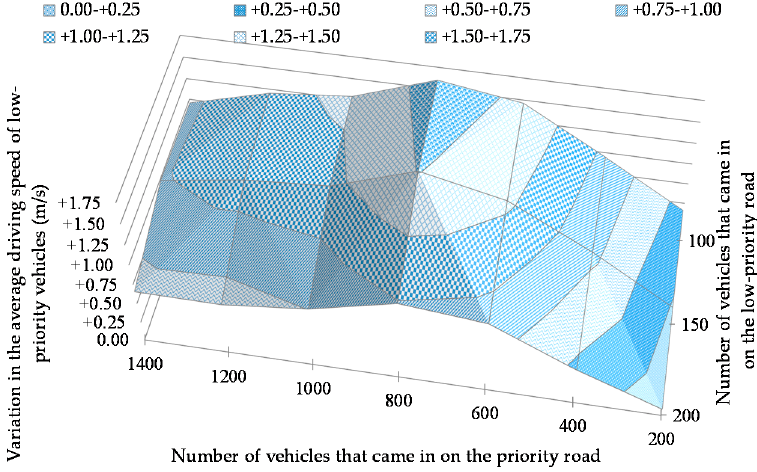
Figure 18. Variation in the average driving speed of low-priority vehicles when the number of vehicles that came in was varied. The average driving speed was the average for the entire percentage range of self-driven vehicles.